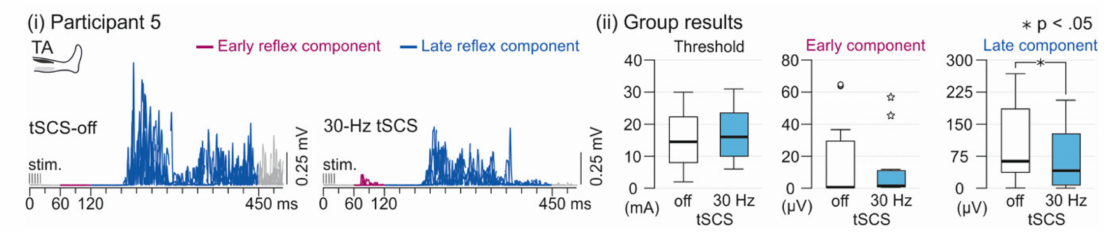
Figure 2. E ff ect of tSCS on spinal reflex activity. ( i ) Rectified electromyographic (EMG) responses of tibialis anterior (TA) to distal tibial nerve stimulation, applied to evoke a spinal reflex in the tSCS-o ff and the 30-Hz tSCS conditions in one participant. Early reflex components (purple lines) were identified within time windows of 60–120 ms post-stimulation train onset (stim.), and late reflex components (blue lines) within 120–450 ms. Shown are four (tSCS-o ff ; one reflex excluded due to pre-activation) or five repetitions superimposed; participant 5, less a ff ected lower limb. Note the shorter duration of the late reflex component under tonic 30-Hz tSCS. ( ii ) Group results of spinal reflex thresholds and TA EMG-root mean square (RMS) values associated with the early and late reflex component, respectively, during tSCS-o ff and 30-Hz tSCS conditions. The EMG-RMS of the late component was significantly reduced under tonic 30-Hz tSCS (asterisk; p < 0.05). Box plots represent medians by bold horizontal lines within boxes that span the interquartile range (IQR). Whiskers extend to the smallest and largest values that are not outliers (here, values between 1.5 and 3 times the IQR of the upper quartile; shown as separately plotted points) or extreme values ( > 3 times the IQR of the upper quartile; white